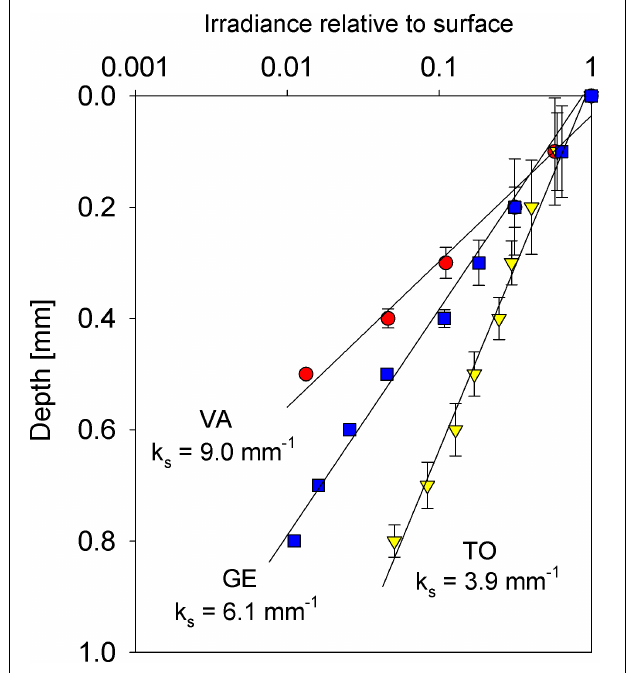
FIGURE 7 | Vertical profile of spectrally averaged irradiance (percentage of incident irradiance) in intertidal sediments of the three sampling sites Vista Alegre (VA), Gafanha da Encarnação (GE) and Torreira (TO). Numbers are the downwelling light attenuation coefficients (k s ) for each type of sediment. Mean values of three replicates. Error bars represent one standard